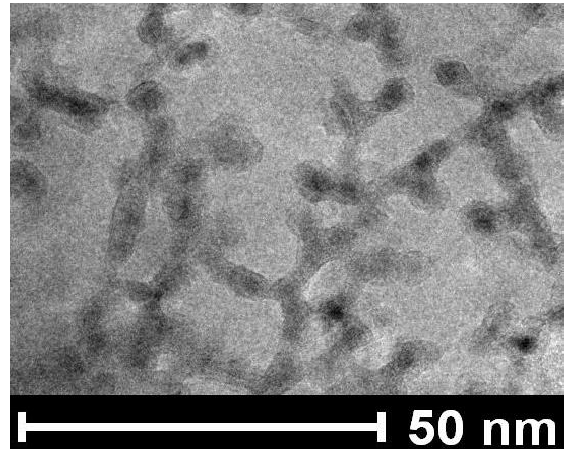
Figure 1. TEM Image of Si NW conformed in the growth process with connecting nanoparticles on silicon amorphous nanofilm.